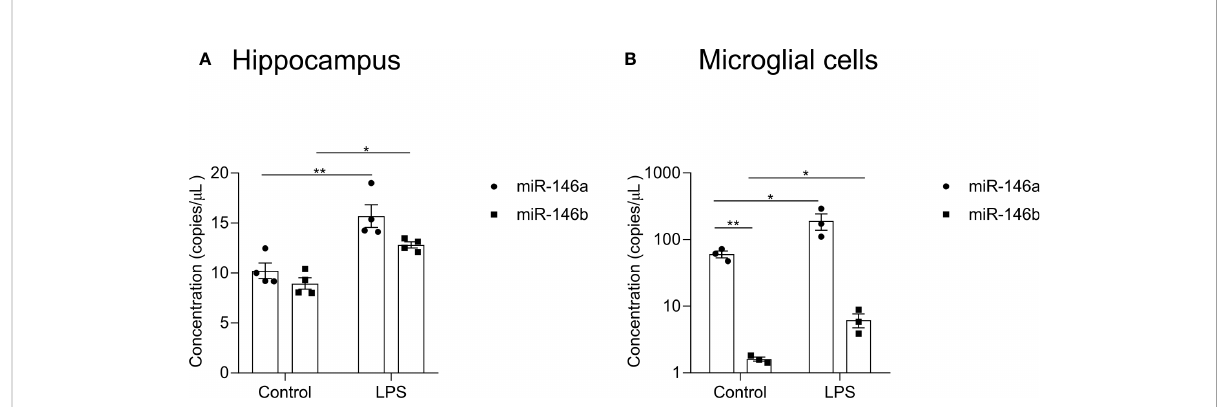
FIGURE 2 Expression of miR-146a/b in hippocampal tissue and microglia cells from WT mice. The expression analysis was performed in mice injected with LPS in saline or equal volume of saline (control). (A, B) miR-146a/b expression in the hippocampus and microglial cells. Number of animals = 3- 4. Data are represented as mean ± SEM; * p < 0.05, ** p < 0.01 (Two-way ANOVA with Tukey ’ s multiple comparison